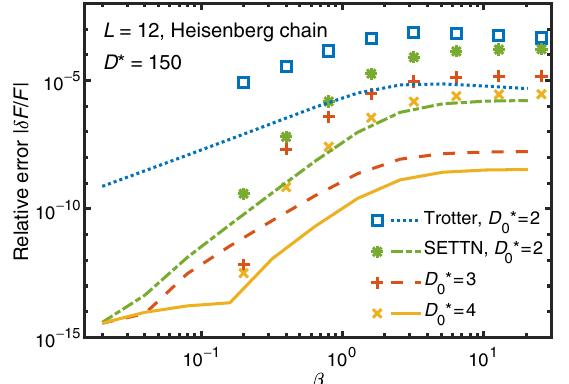
FIG. 15. Comparison between the first-order Trotter-Suzuki and the series-expansion initialization schemes on an L ¼ 12 Heisenberg chain. Two sets of data are shown from calculations starting with τ 0 ¼ 0 . 1 (symbols) and τ 0 ¼ 0 . 01 (lines). After the initialization, the MPO e − τ 0 H is fed into an XTRG evolution, where the number of retained bond states is set to D (cid:3) ¼ 150 . The same color represents the same type of initialization; i.e., blue represents Trotter initialization, while green, red, and yellow represent initialization by SETTN with bond dimensions D (cid:3) 0 ¼ 2 , 3, 4 ( D 0 ¼ 4 , 5, 8),